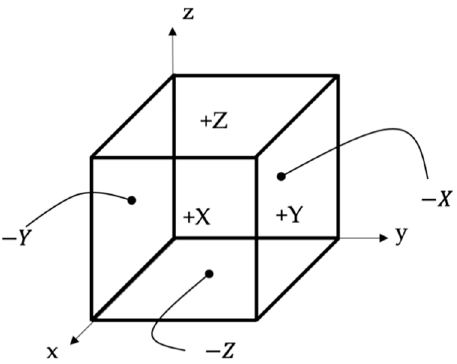
Figure 2. The six orientations considered in the automated debinding simulation